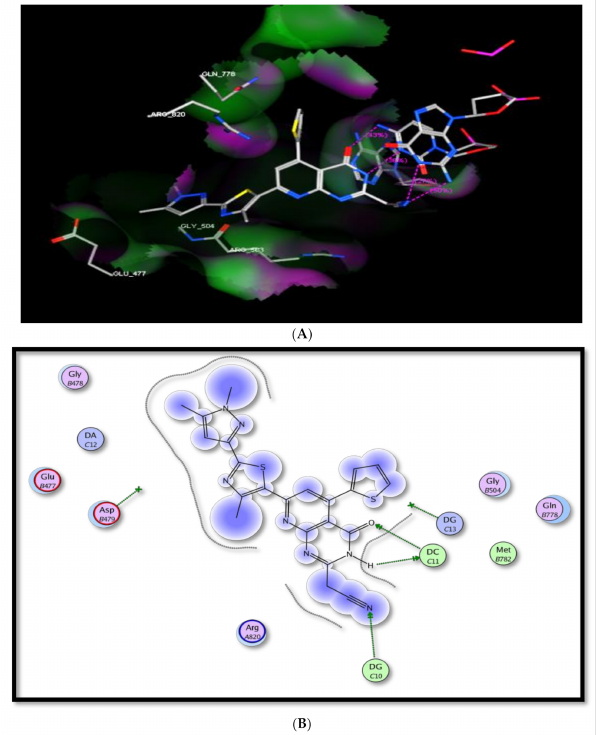
Figure 6. The suggested binding mode of compound 8 within topoisomerase II. ( A ) 3D binding mode within the active site. ( B ) 2D binding mode within topoisomerase II.